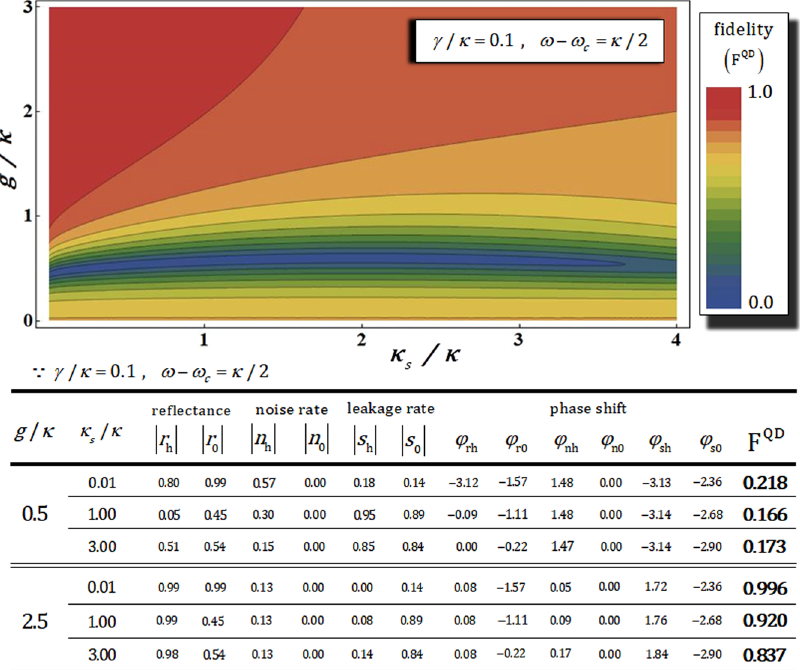
Figure 8. The plot represents the fidelity F QD (the QD-cavity system) of the output state according to side leakage rate κ s / κ and coupling strength g / κ with fixed γ / κ = 0.1 and ω − ω c = κ /2. Values of fidelity, reflectances, noise rates, leakage rates, and phase shifts are listed in the Table, according to differences in g / κ and κ s / κ . This plot and Table obviously show that fidelity approaches 1 when g / κ (coupling strength between QD and cavity) increases, and κ s / κ (side leakage rate of cavity) simultaneously decreases, despite occurred vacuum noise ˆ N in dipole operation and sideband leakage, absorption ˆ S in